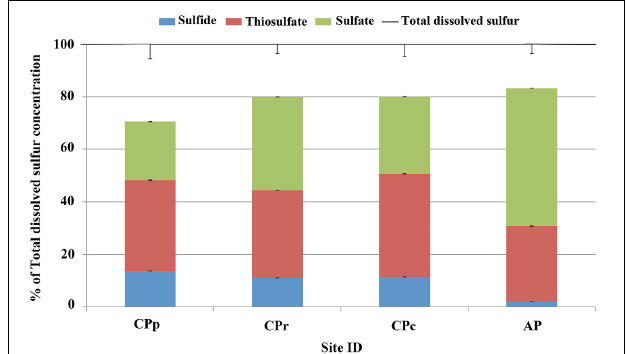
FIGURE 2 | Arsenic speciation as a percentage of total dissolved arsenic at Champagne Pool. CPp, central pool; CPr, rim of pool; CPc, outflow channel; AP, “Artist’s Palette” terrace. DTA, dithioarsenate; TriTA, trithioarsenate; MTDMA, dimethylmonothioarsenate.